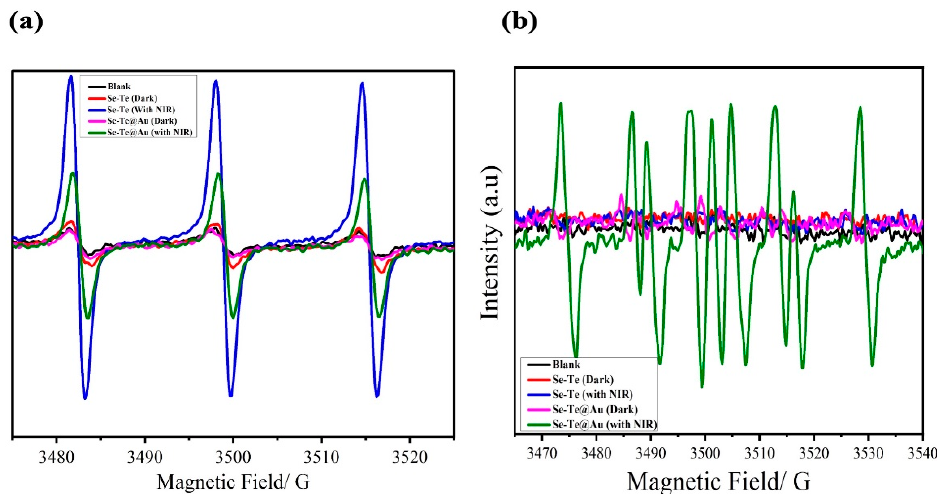
Figure 9. Electron spin resonance analysis. Spectra of single oxygen of control sample ( a ): Se-Te without NIR irradiation (red line) and irradiated with NIR light (blue line), Se-Te@Au without NIR (pink line) and with NIR (green line), and singlet oxygen species in the dark and exposed to visible light; ( b ) hydroxyl radical generation from the prepared samples.